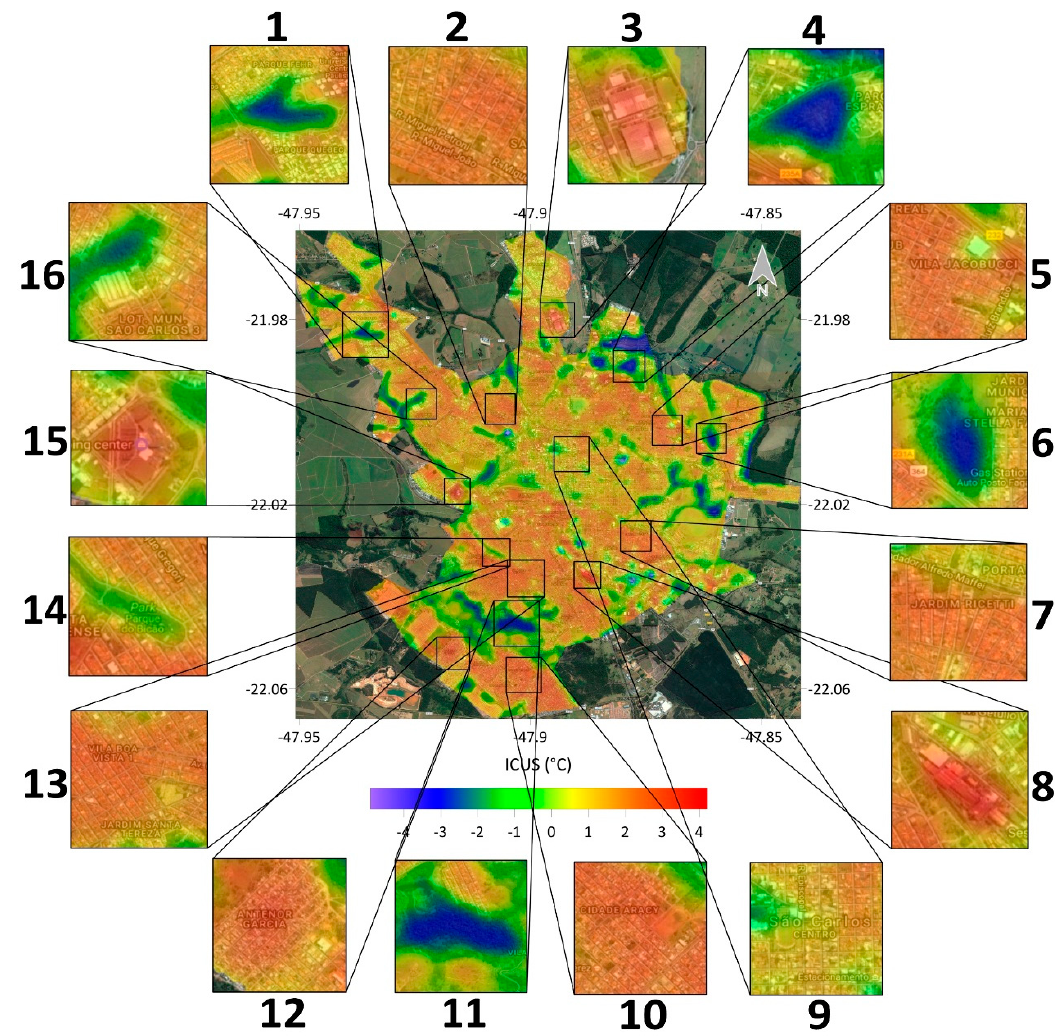
Figure 4. SUHI obtained from the average of all images (2015–2017).